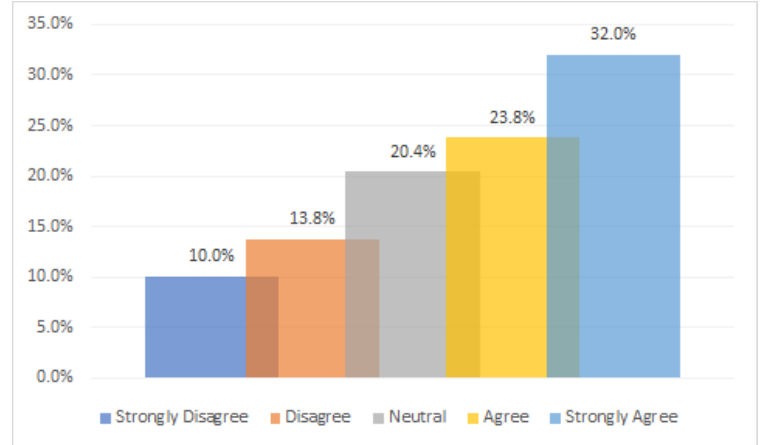
Figure 9. Answers to a Likert five-point scale to the question: Do you think tests employed in the dEERs have helped enhancing motivation?